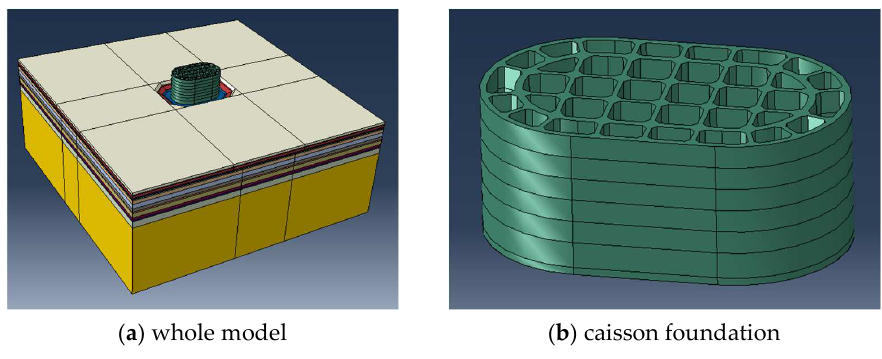
Figure 9. 3-D Finite element model.